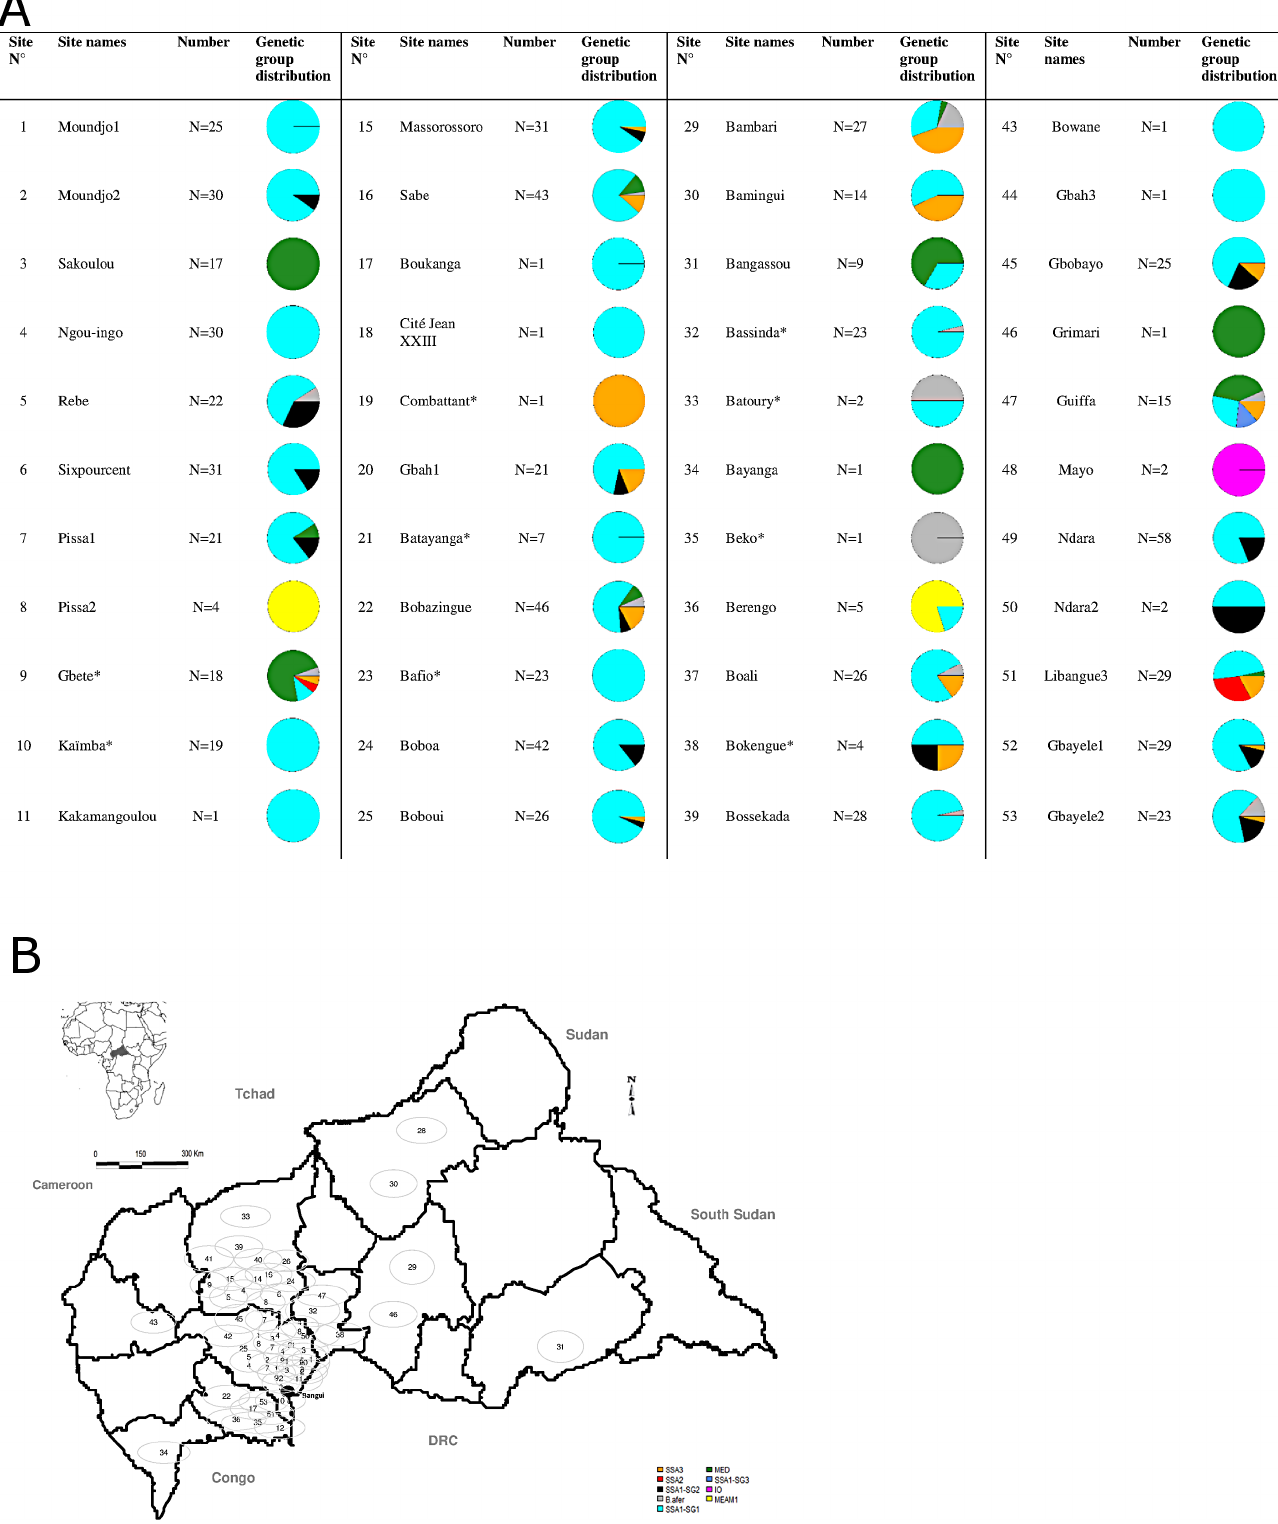
Fig 4. Distribution of B . tabaci putative species and genetic groups at the sampled sites in Central African Republic using 898 individuals. Each circle represents a site with a numberreferencedin the table belowand each color correspondsto a geneticgroup.